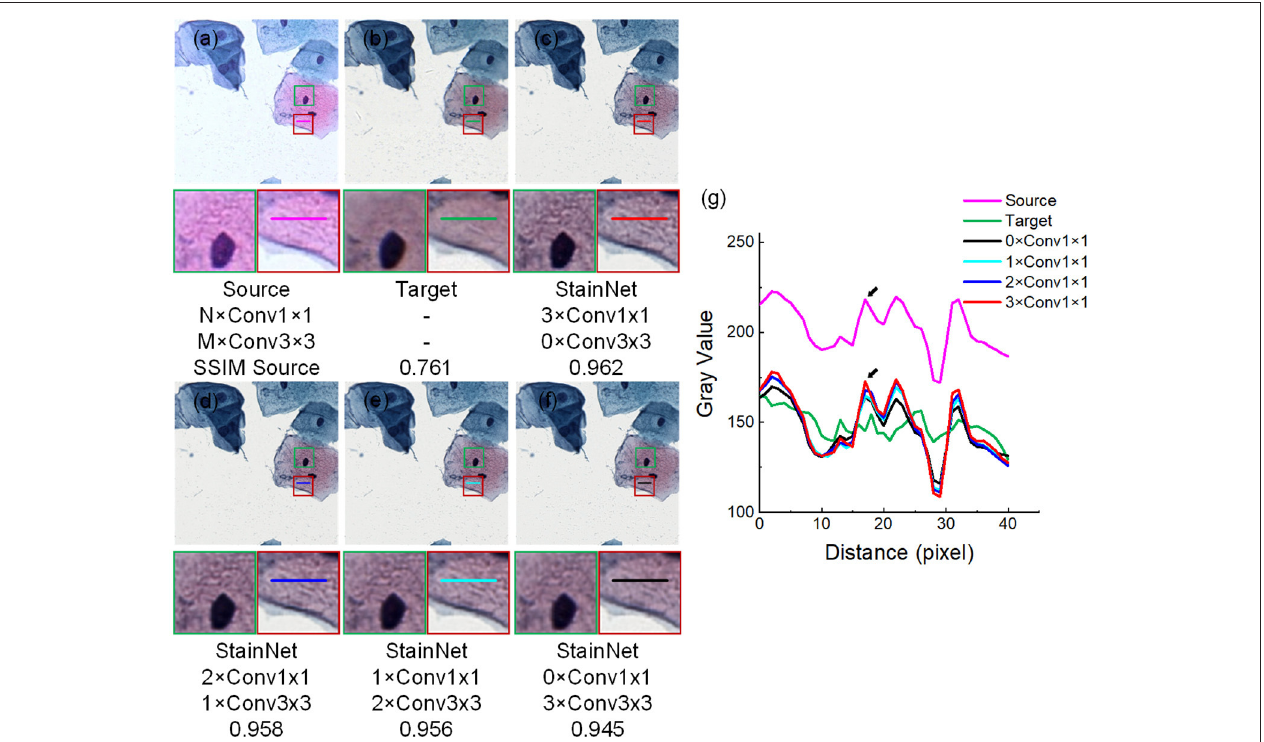
FIGURE 9 | Effects of 1 × 1 and 3 × 3 convolutions. NxConv1x1 and MxConv3x3 refer to the number of 1 × 1 convolution and 3 × 3 convolutions. StainNet contains only three convolution layers, so the total number of 1 × 1 convolution and 3 × 3 convolutions is three, that is, M + N = 3. The image in the dashed box is enlarged below. Gray value profiles of the straight lines in (a–f) are shown in the line chart (g) .